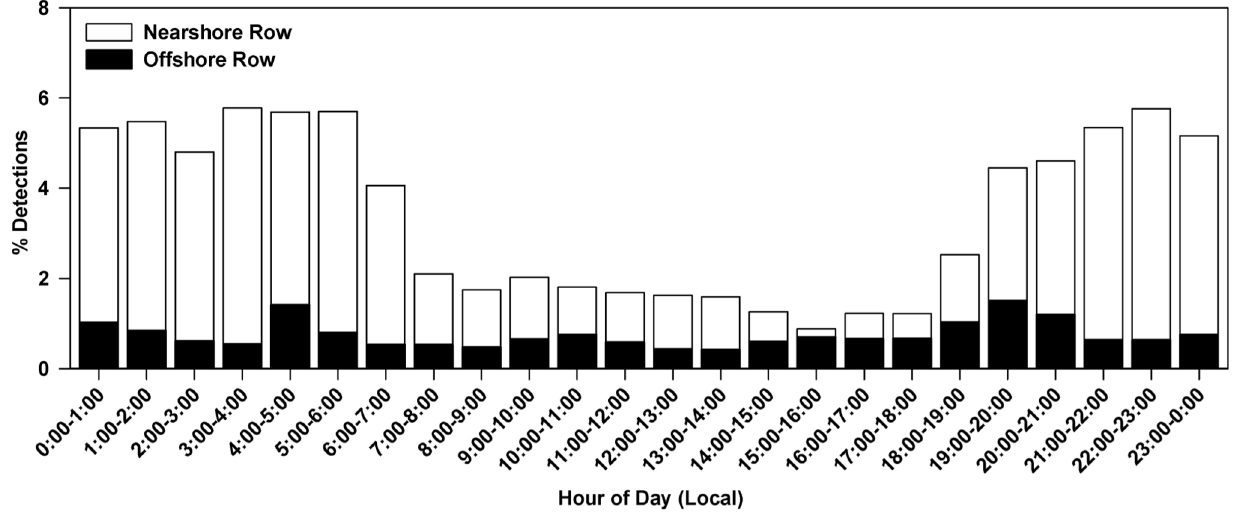
Figure 4. Distribution of lemon shark detections by receiver row and by hour of day . Nearshore receivers were located 250 m from the beach while offshore receivers were 1250 m from the beach.